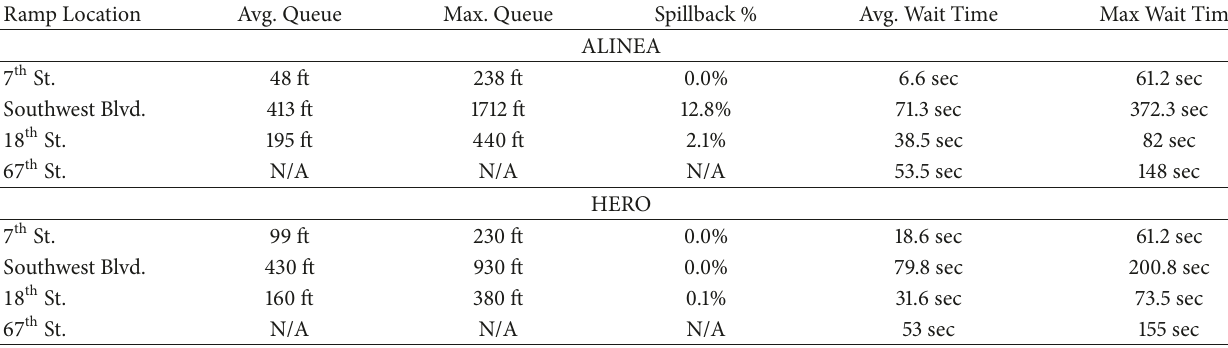
Table 5: Queue length and waiting time results for ALINEA and HERO ramp control.